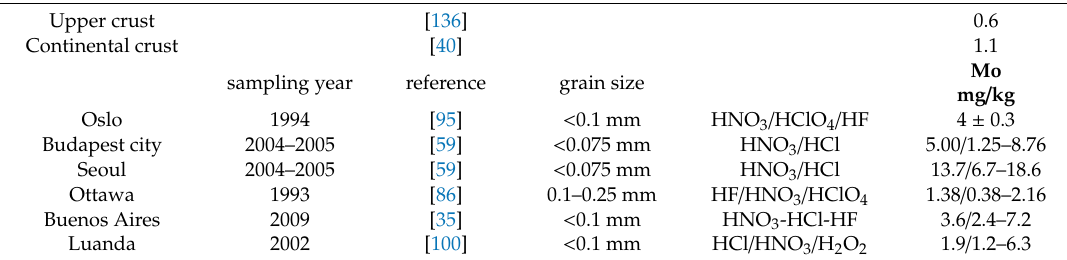
Table A32. Molybdenum in road dust.